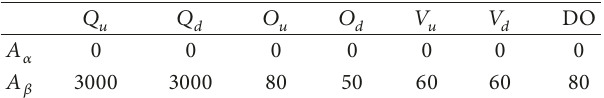
Table1:Thevaluesof 𝐴 𝛼 and 𝐴 𝛽